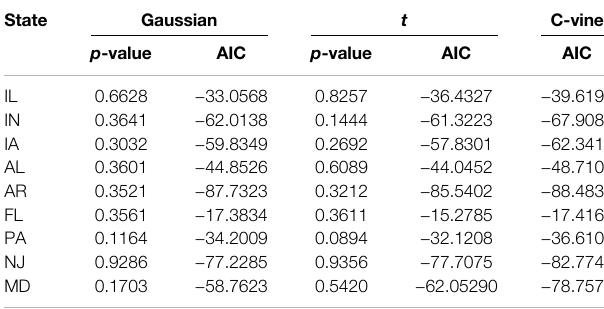
TABLE 4 | Vine copula estimation results of data sets in each state. TABLE 5 | GOF test results of the data sets in different